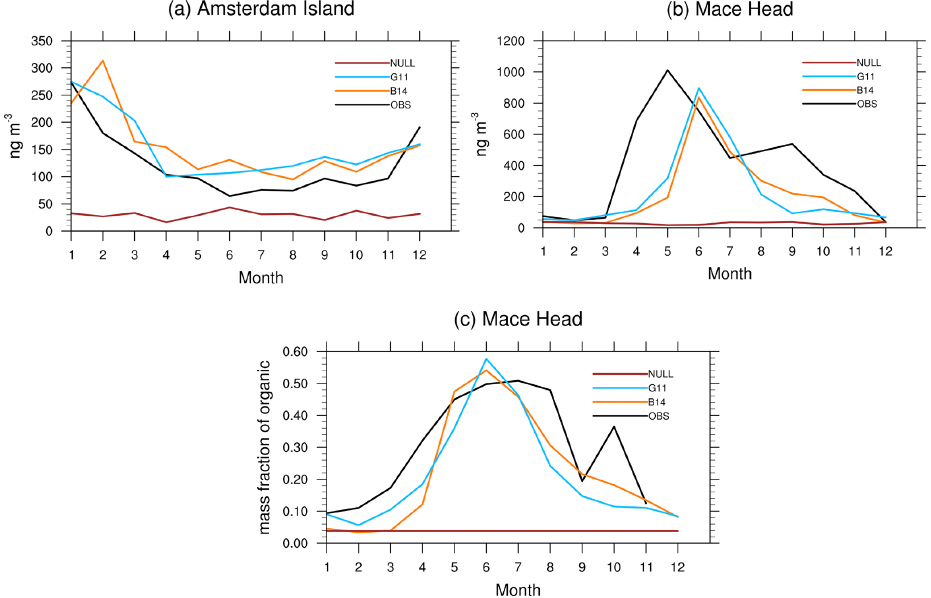
Figure 2. Monthly averaged concentrations of MOA at (a) Amsterdam Island and (b) Mace Head, Ireland, and (c) monthly averaged mass fraction of MOA in SSA at Mace Head, Ireland. The locations of Amsterdam Island and Mace Head, Ireland, are shown in Fig.